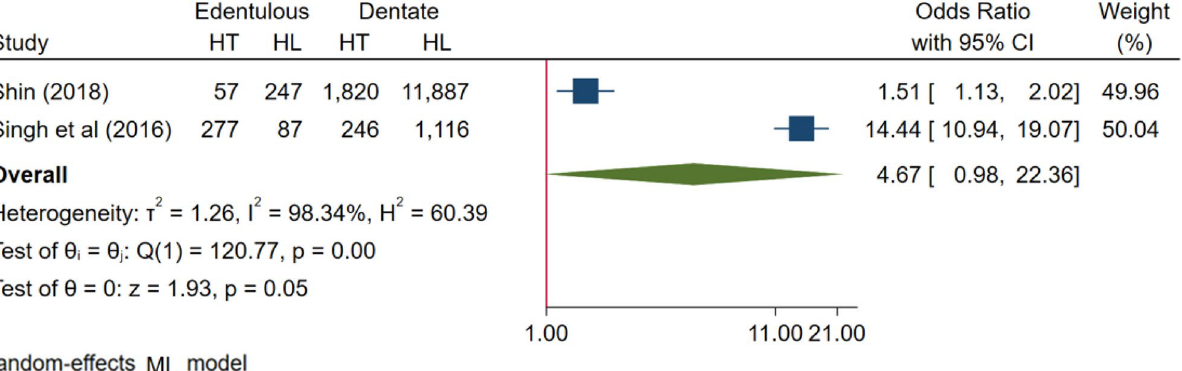
Figure 3. Forest plots of the Odds ratios with corresponding 95% Cis of studies on dentate/edentulous and risk of